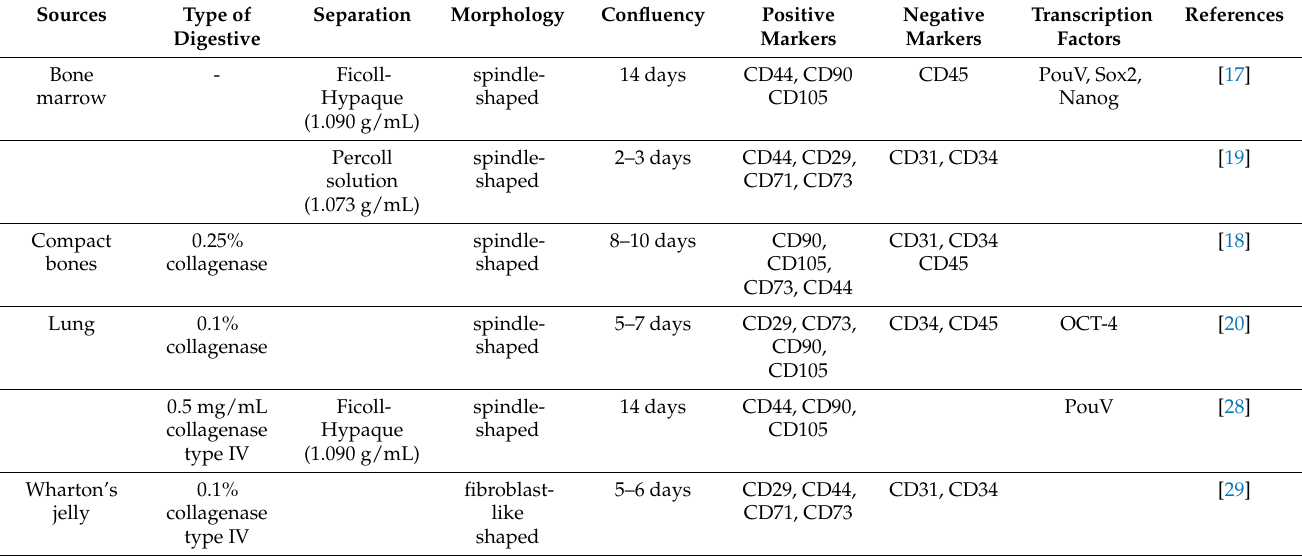
Table 1. Comparison of chicken MSCs derived from different